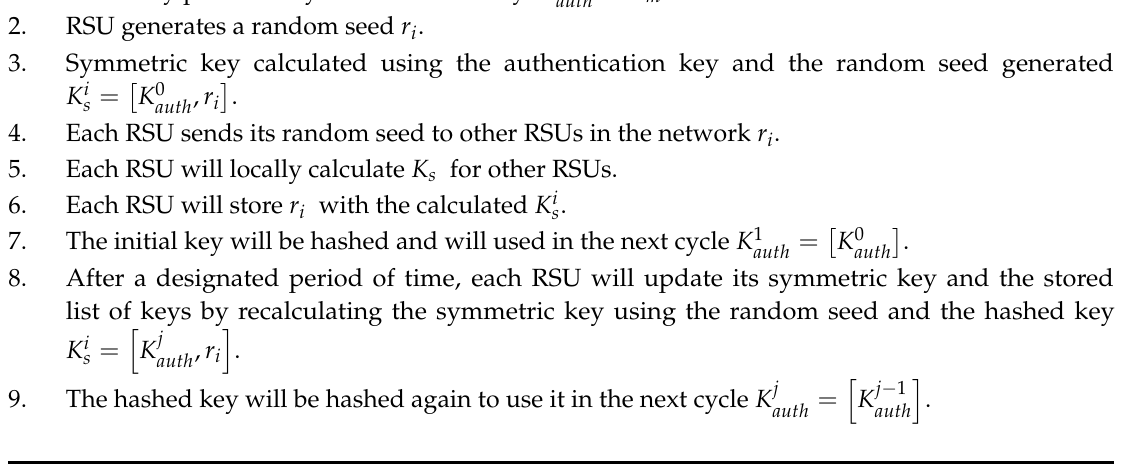
Algorithm 1. Symmetric key generation at